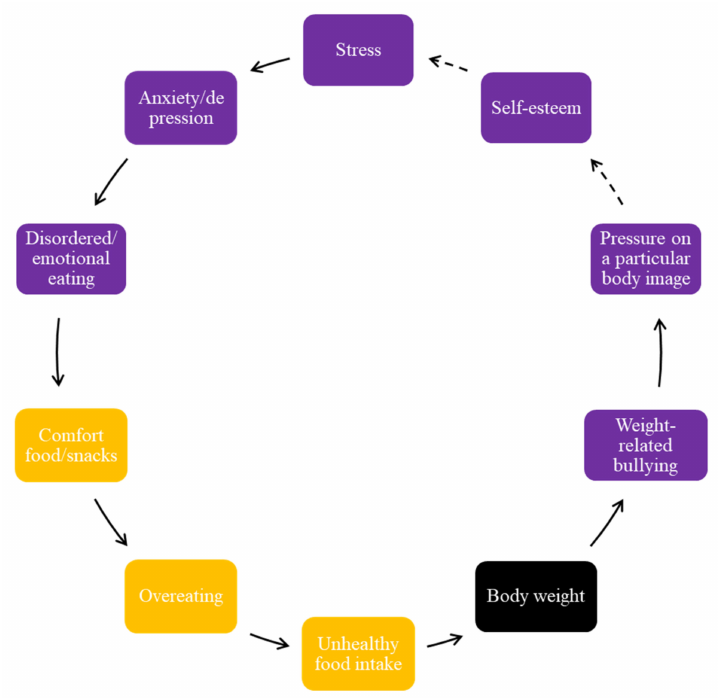
Figure 5. Psychological distress, body weight, and weight-related